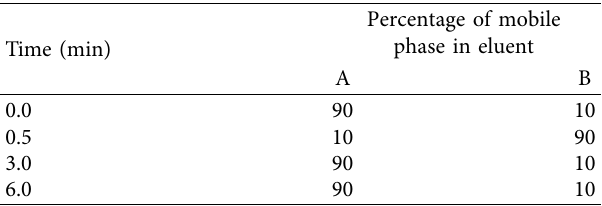
Table 1: Gradient settings of mobile phase for vardenafil hydro- chloride trihydrate